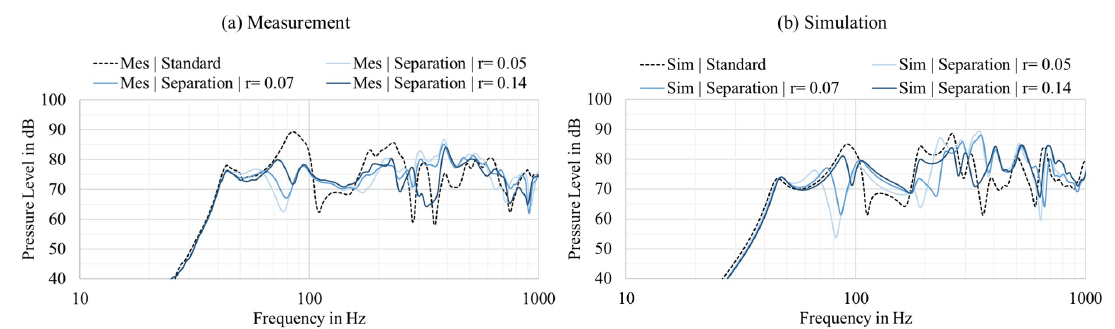
Figure 14. Influence of the radius in the separation plate: ( a ) measurement; and ( b )